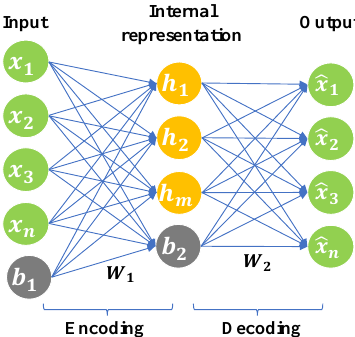
Figure 2. The structure of the autoencoder (AE) neural network.